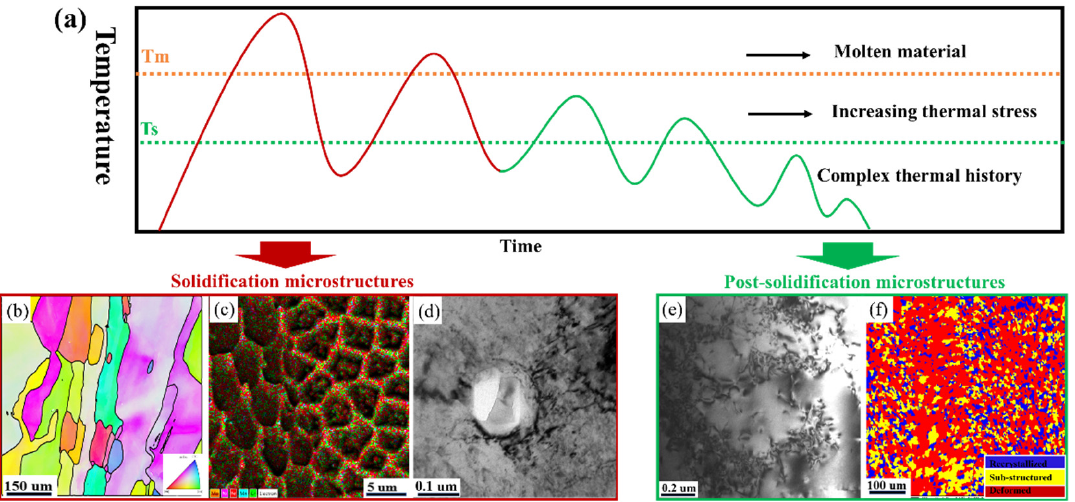
Figure 11. ( a ) Typical thermal cycle curves in the DED process and the typical time division of solidified and post-solidified microstructures; ( b – f ) images of macrocrystalline grains, solidified cells, nano oxides, dislocation cells, and recrystallized grains.